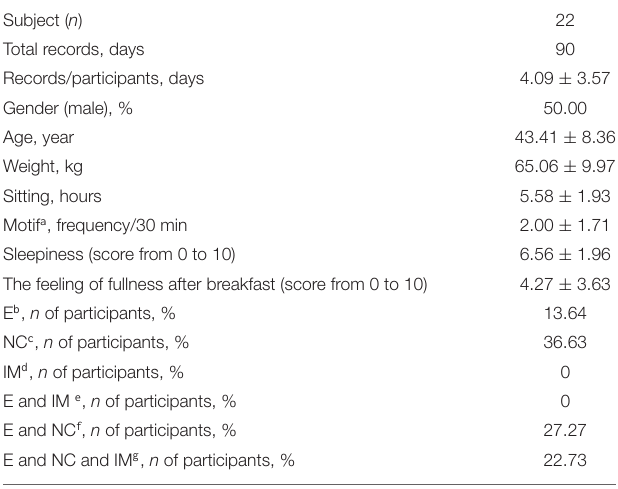
TABLE 4 | The BIC values corresponding to each K -values (window size = 5, β = 50, λ = 0.001).